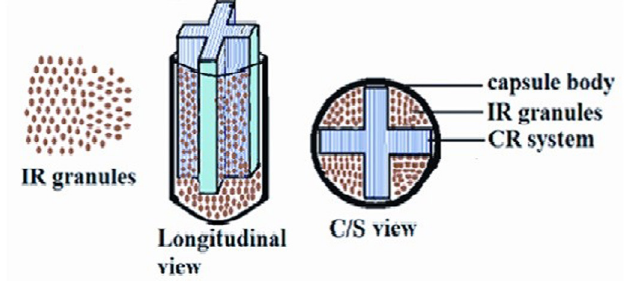
FIGURE 3 - Bifunctional capsular dosage form consisting of CR gastroretentive system of clarithromycin and IR granules of ranitidine